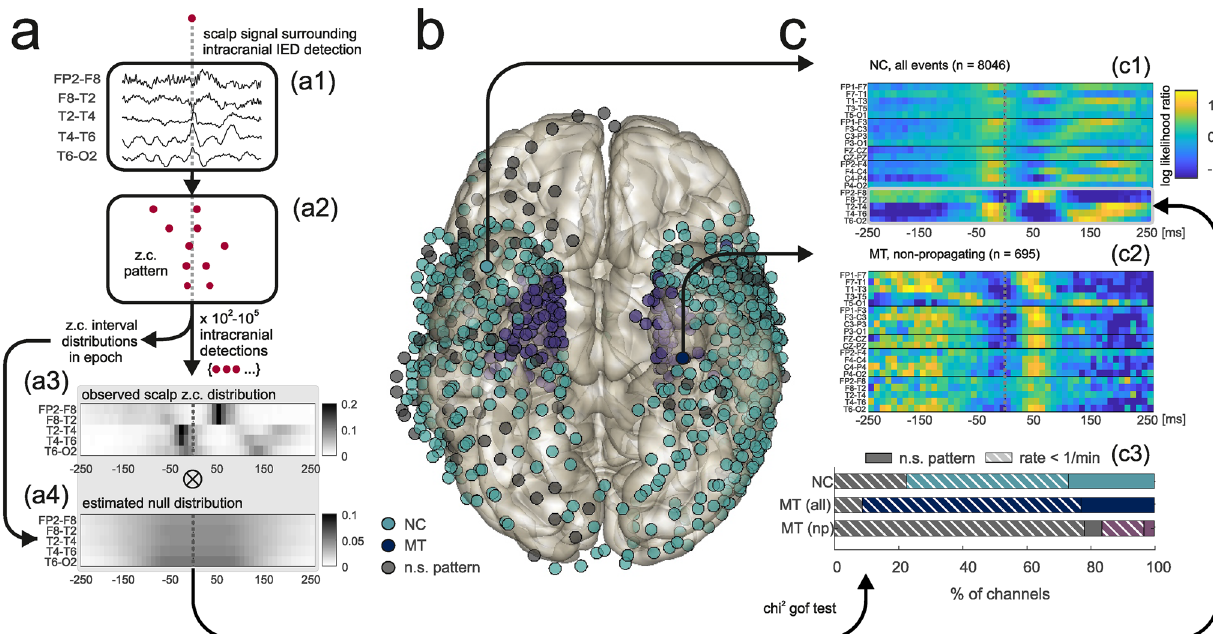
Figure 2. Analysis of zero-crossing patterns triggered by intracranially detected IEDs. ( a ) Derivation of a template (for clarity, only the right lateral temporal chain of scalp electrodes is illustrated). ( a1 , a2 ) Transformation of the scalp signal ( a1 ) triggered by an intracranial IED detection (dotted gray line) into a zero- crossing pattern ( a2 ). ( a3 ) Intracranial IED detection-triggered scalp zero-crossing distribution. ( a4 ) Estimated null distribution. ( b ) Intracranial IED detection-triggered zero-crossing distributions differed significantly from null distributions at both NC (light blue) and MT (dark blue) sites. Channels not associated with significant patterns are shown in gray. ( c1 , c2 ) Examples of templates derived from IEDs detected in an NC channel ( c1 ) and from nonpropagating IEDs detected in a MT channel ( c2 ). Color codes the pattern of log-likelihood of a scalp zero-crossing for a projected intracranial IED (dotted gray lines). ( c3 ) Proportions of channels associated with significant zero-crossing patterns depending on channel location. Channels with high (> 1/min) detection rates (solid portions of bars) always gave rise to significant templates in NC/MT electrodes (light and dark blue) but not in the case of some nonpropagating MT IEDs (purple). NC neocortical, MT mesial-temporal, np